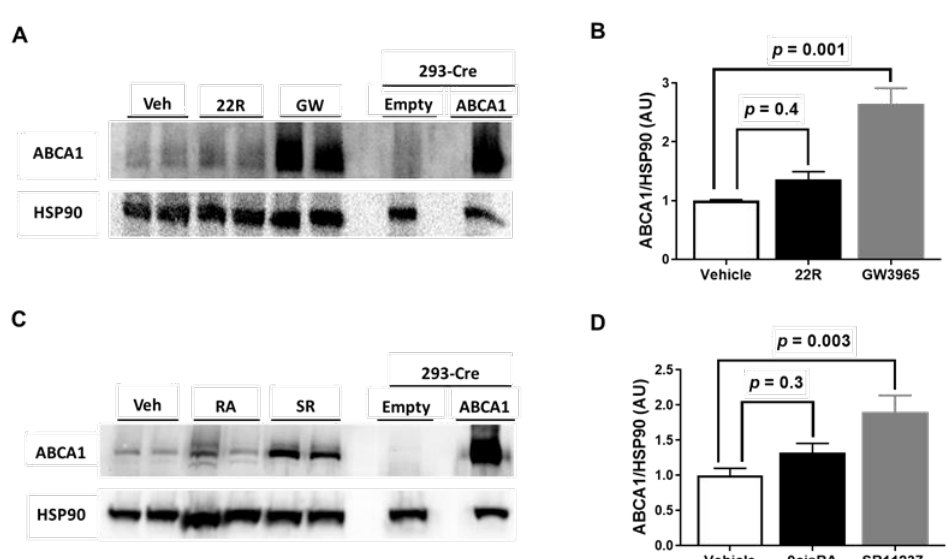
Figure 2. Effect of LXR and RXR agonist treatment on ABCA1 protein expression in immortalized mouse aortic endothelial cells (iMAEC). ( A ) iMAEC were cultured in basal conditions and treated with either vehicle only (Veh), 22(R)-hydroxycholesterol (22R), or GW3965 (GW), and ABCA1 protein from iMAEC lysates were assessed by immunoblotting. ( B ) Quantification of ABCA1 protein in representative immunoblot ( A ) and two other immunoblots (three independent treatments; each with two biological replicates per respective treatment). ( C ) iMAEC cultured in basal conditions and treated with Veh, 9-cis-retinoic acid (RA), or SR11237 (SR), and ABCA1 protein from iMAEC lysates were analyzed via immunoblotting. ( D ) Quantification of ABCA1 protein in representative immunoblot ( C ) and two other immunoblots (three independent treatments; each with two biological replicates per respective treatment). ( A , C ) 293-Cre cells transfected with empty vector plasmid (technical negative control) or ABCA1-expressing plasmid (technical positive control). HSP90 is the housekeeping protein. ( B , D ) AU, arbitrary units; data are mean ± SEM.